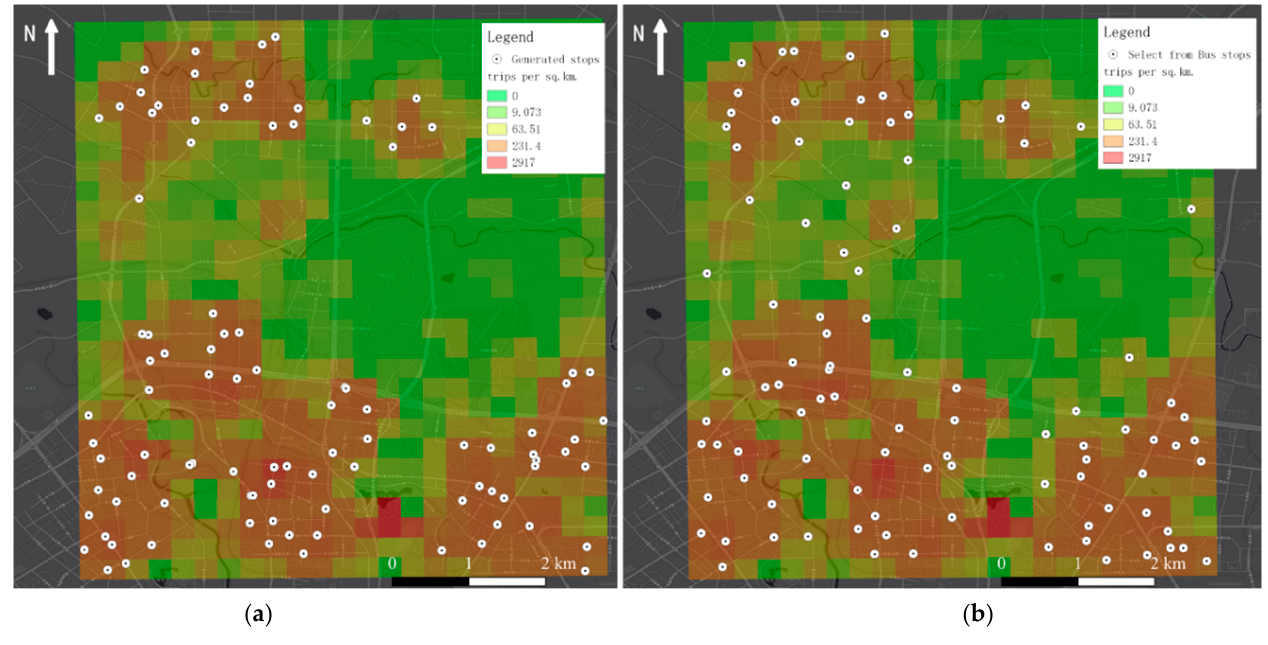
Figure 7. Generated shuttle stops with our method and comparison. ( a ) Generated shuttle stops with our method; ( b ) selected stops from existing bus stops. Table 3. Comparing the service capability of the generated shuttle stops with the existing bus stops.